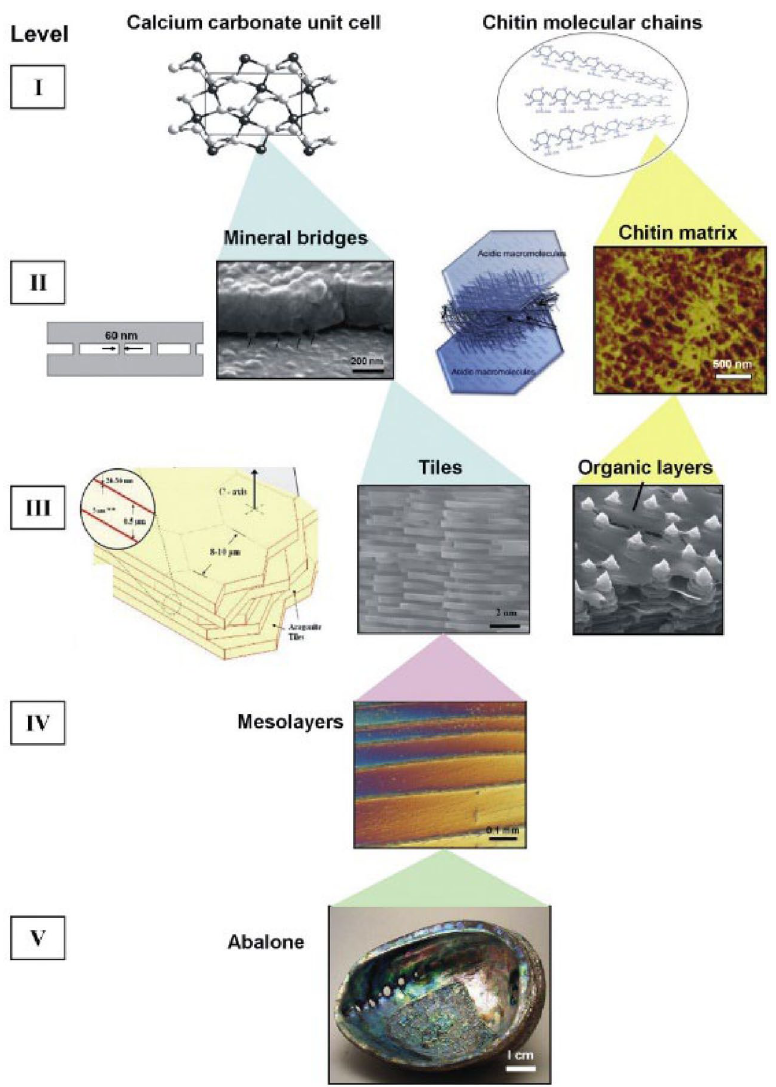
Fig. 24 Five levels of the hierarchical structure of the abalone nacre. (I) Molecular structures of calcium carbonates and chitins. (II) Mineral bridges possessing the sandwich structure. (III) Aragonite tiles and organic layers. (IV) Mesolayers with a thick organic layer separating tile assemblages. (V) The abalone. Reproduced with permission from Ref. [46], © Elsevier Ltd.